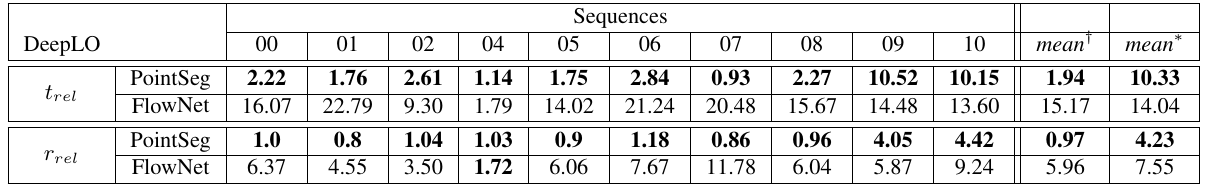
Table 2. Odometry result of DeepLO networks on KITTI dataset.